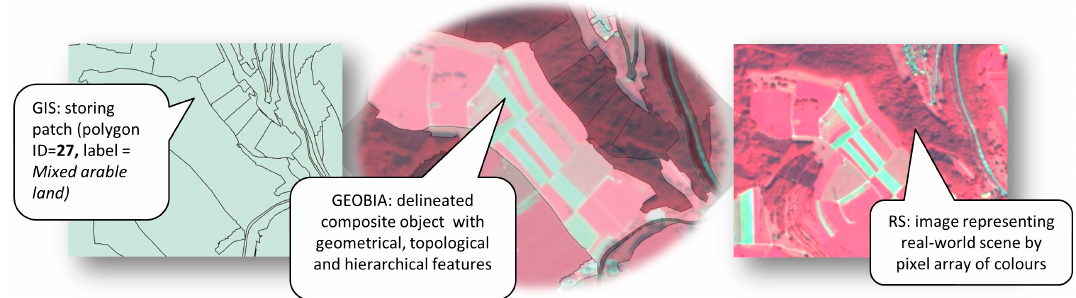
Figure 4. GEOBIA emerged as a paradigm to mediate between the domain of geospatial entities (in particular, crisp areal features such as those in a vector representation) and continuous field representations, such as those in images.